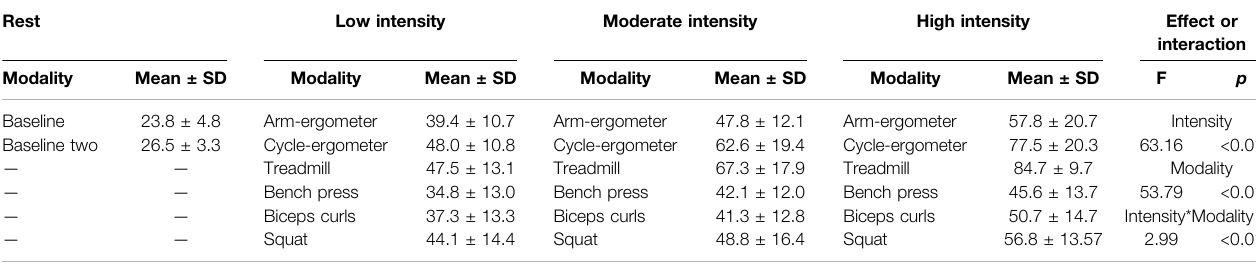
TABLE 2 | Endothelial Shear Stress (in dynes/cm 2 ) by exercise intensity and modality. Rest